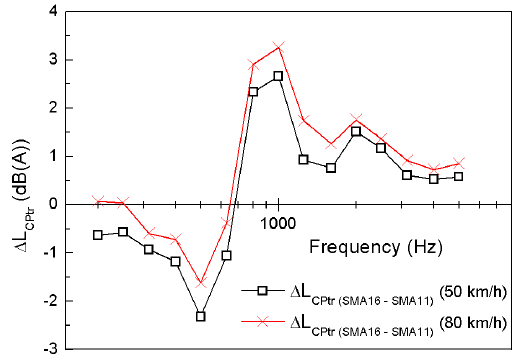
Figure 9. ∆ L CPtr values at every one-third octave band frequency of the sound spectra (50 and 80 km/h). According to these results, the relationship between the different frequencies of the tire/pavement sound spectrum and the different wavelengths of the texture spectra should be further